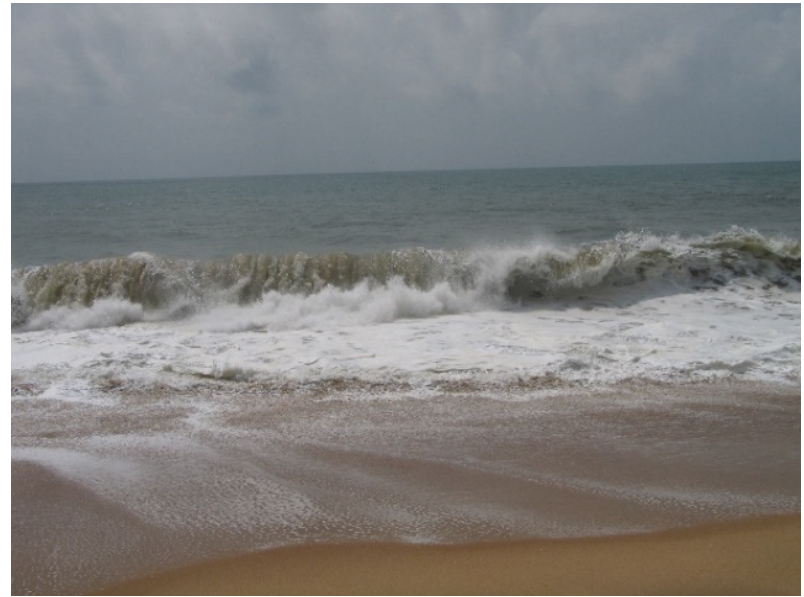
Figure 10. Plunging breaker at the beach step on the reflective beach at Anloga, Ghana. Note the reddish-brown color of the water in the overturning wave, which is caused by suspended sediment particles that have been picked up by the breaker.